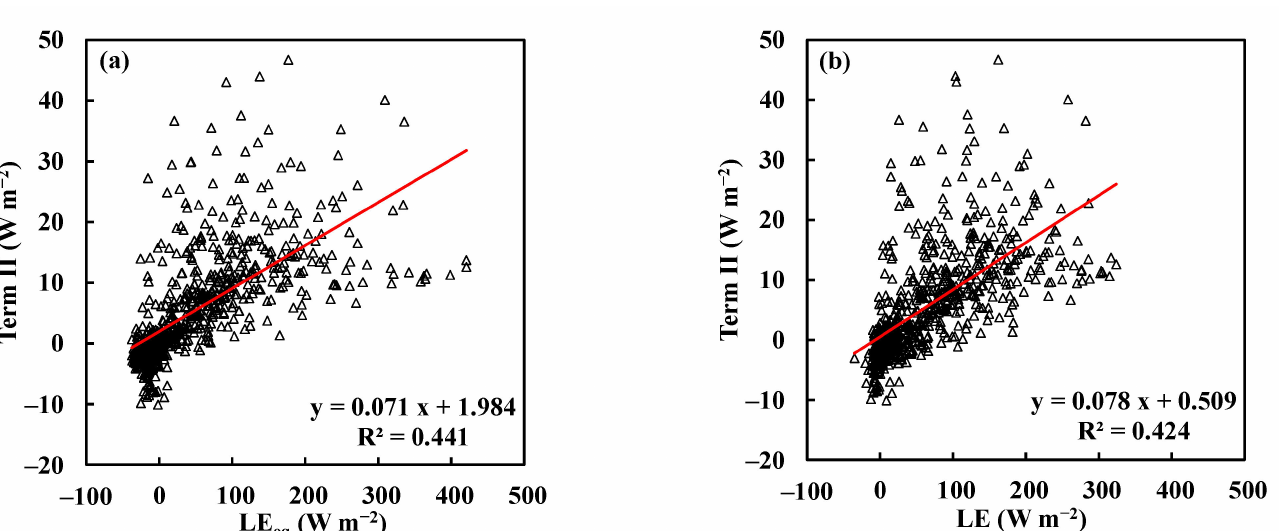
Figure 10. Scatter plots of the three terms in the non-parametric method as a function of R n − G for LE and H above the grassland ( a , b ), peat bog ( c , d ), and forest ( e , f ). Equations (7) or (8) represent the condition that should be satisfied if the N-P method is applied for estimating LE. Figure 11 shows the relationship between term II and LE eq along with the measured LE for the three sites. In Figure 11, the slopes for the grassland and peat bog sites are positive, but those for the forest site are negative. This is because when R n for the forest site is large, most of the energy (57%, see Table 2) is distributed to H for warming up the air; hence, the difference between T s and T a is reduced which results in a smaller term II. Figure 11 also reveals that term II is about ± 10% (from − 0.051 to 0.083) of the equilibrium evapotranspiration (Figure 11a,c,e).